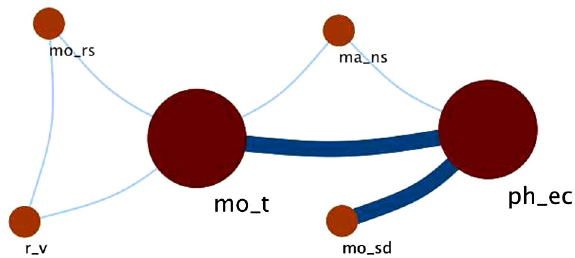
FIG. 2 (color online). Sample epistemic network visualizing the epistemic frame given by an example of an interview